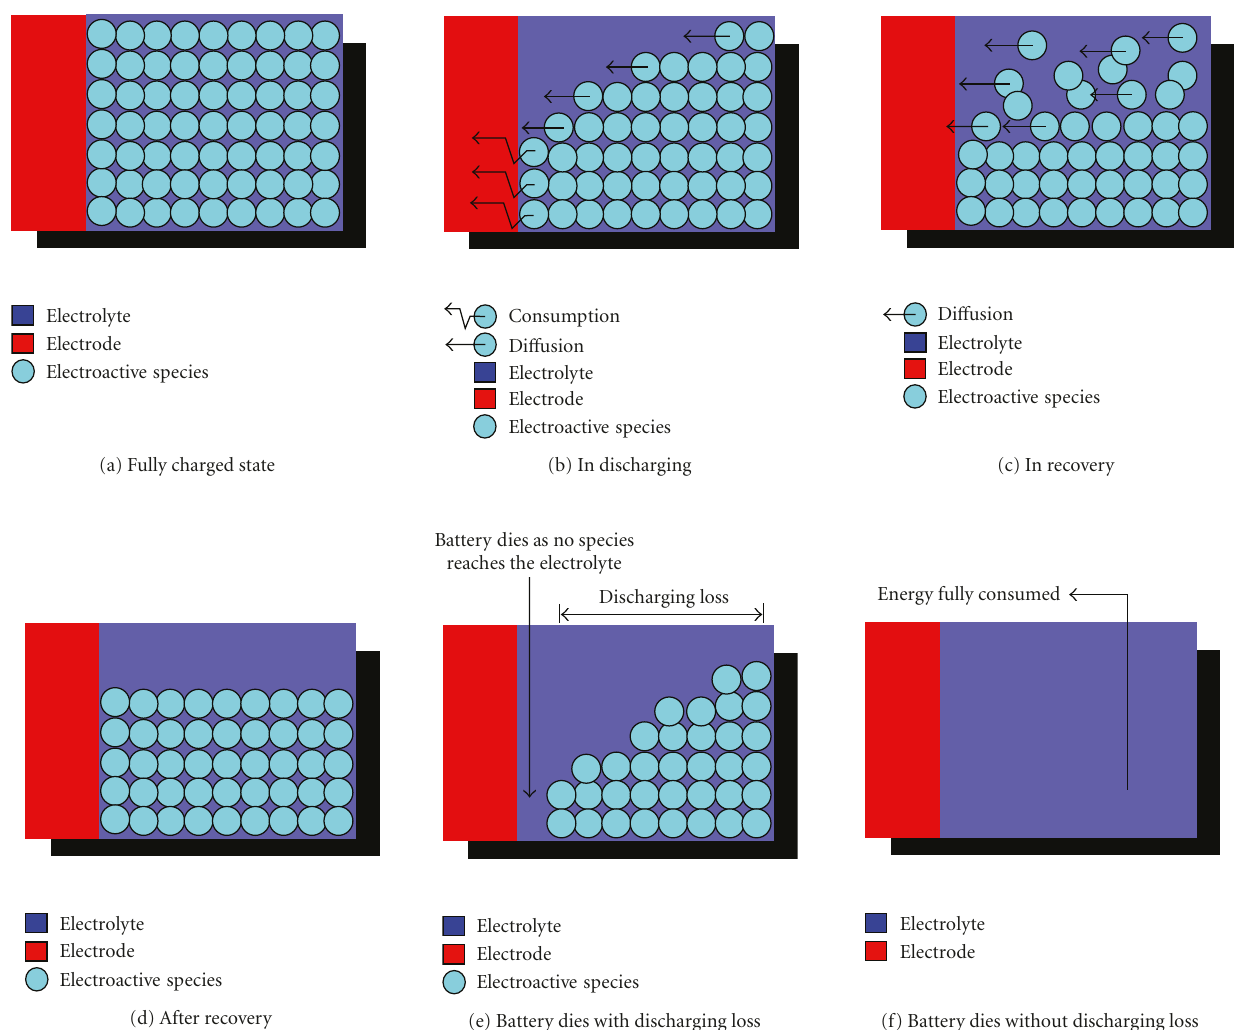
Figure 2: Battery operation at di ff erent